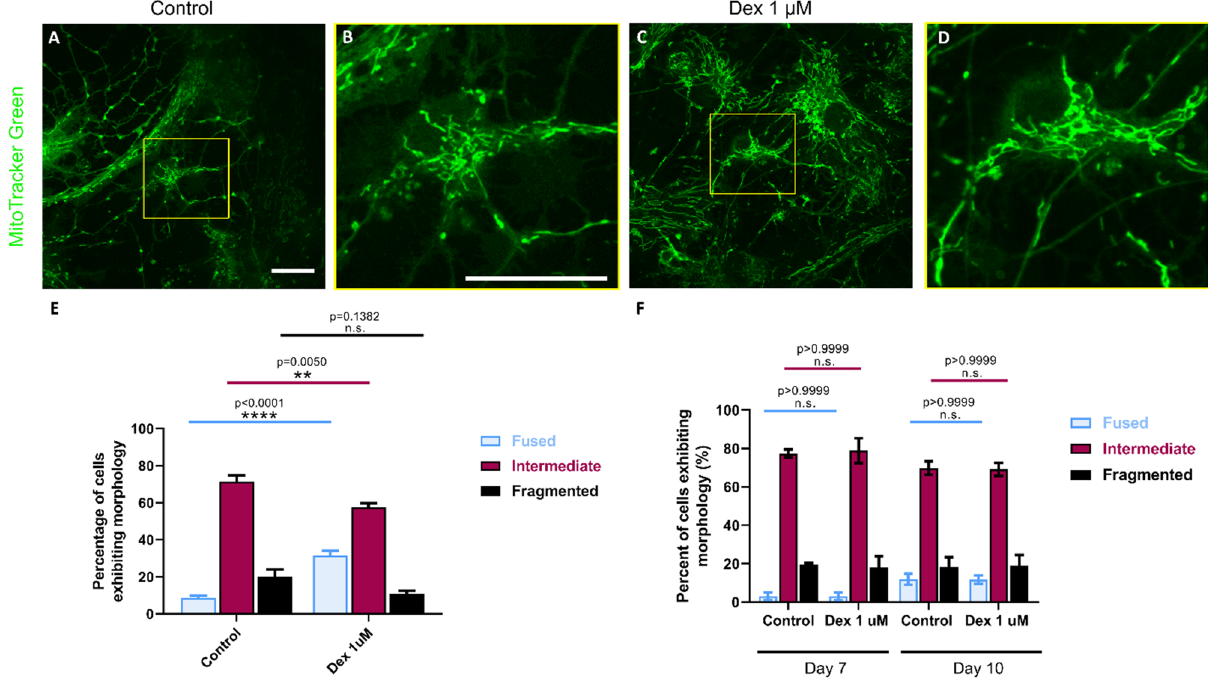
Figure 4. Exposure to dexmedetomidine 1 μM resulted in a hyperfused mitochondrial network. Representative live-fluorescent images of neurons stained with MitoTracker green ( A ) control and ( B ) dexmedetomidine 1 μM. Magnification of the region of interest in ( C ) control and ( D ) dexmedetomidine 1 μM cells. ( E ) Day 4 quantification of predominant mitochondrial morphology in each treatment based on a previously described morphology scale: (1) fused: control = 8.519 ± 1.357, dexmedetomidine 1 μM = 31.65 ± 2.460, (2) intermediate: control = 71.45 ± 3.439, dexmedetomidine 1 μM = 57.53 ± 2.254 and (3) fragmented: control = 20.03 ± 3.941, dexmedetomidine 1 μM = 10.82 ± 1.52. Values are mean ± SEM F (2, 48) = 30.5, ****p < 0.0001, **p = 0.005 by one-way ANOVA with Tukey’s post hoc analysis for multiple comparisons. Bars indicate ± SEM. Scale bars indicate 20 μm n = 8 (control) and n = 10 (dexmedetomidine 1 μM) dishes per condition, 15–20 images per plate. ( F ) Days 7 and 10 quantification of predominant mitochondrial morphology in each treatment: (1) fused: control D7 = 3.077 ± 1.942, control D10 = 11.93 ± 2.94, dexmedetomidine 1 μM D7 = 3.04 ± 2.032, dexmedetomidine 1 μM D10 = 11.72 ± 2.15, (2) intermediate: control D7 = 77.41 ± 2.039, control D10 = 69.8 ± 3.455, dexmedetomidine 1 μM D7 = 78.85 ± 6.503, dexmedetomidine 1 μM D10 = 69.14 ± 3.401 and (3) fragmented: control D7 = 19.51 ± 0.8, control D10 18.27 ± 4.989, dexmedetomidine 1 μM D7 = 18.11 ± 5.725, dexmedetomidine 1 μM D10 = 19.14 ± 5.416. Values are mean ± SEM F (6, 39) = 1.314, P = 0.274 by two-way ANOVA with Tukey’s post hoc analysis for multiple comparisons. Bars indicate ± SEM n = 3 (control and dexmedetomidine 1 μM D7), n = 4 (control D10) and n = 7 (dexmedetomidine 1 μM D10) dishes per condition, 15–20 images per plate. ( A , C , B , D ) show the same scale,